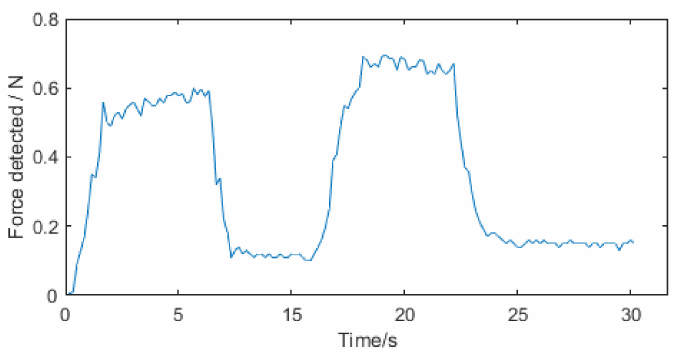
Figure 13. The force detected by traditional force sensor during a catheter push.